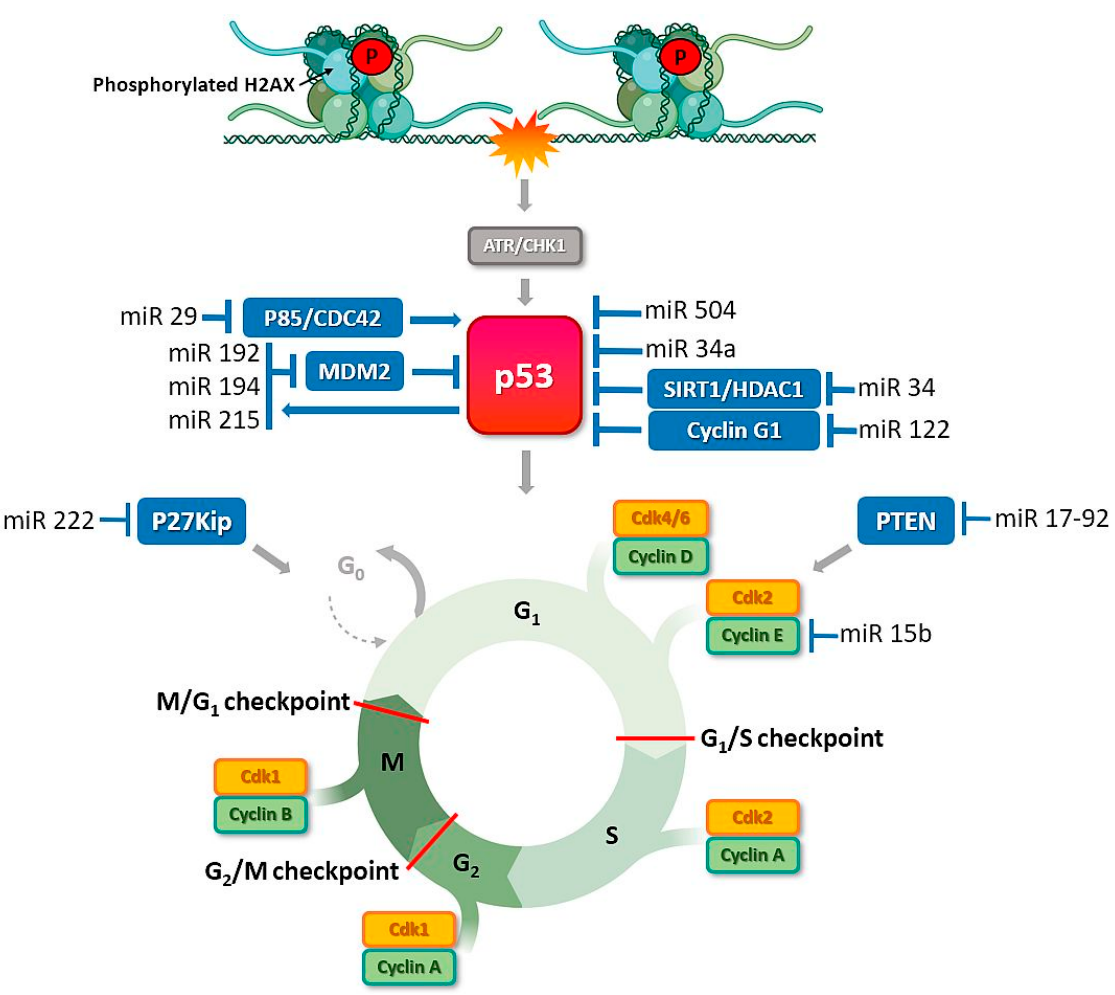
Figure 3. P53-induced miRNAs control cell cycle and cell survival in ovarian cancer. DNA damage stimulates ATR or DNA-PK kinases that activate TP53 to directly induce many kinds of miRNAs that repress cell-cycle regulators or allow to DNA repair. ATR transduces the DDR signal by phosphorylation of the checkpoint kinase CHK1, which results in cell cycle arrest and DNA repair. MiRNAs, e.g., miR-34a, a direct transcriptional target of TP53, participate in the regulation of TP53 activity. Activated TP53 translocates into the nucleus where it induces the transcription of several targets involved in cell cycle control, DNA repair, or apoptosis. DDR-related proteins that are MiRNAs recognizable are shown in blue box.